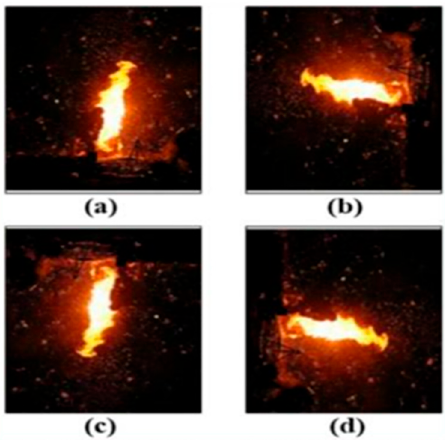
Figure 2. Original image ( a ); 90 ◦ rotation image ( b ); 180 ◦ rotation image ( c ); 270 ◦ rotation image ( d